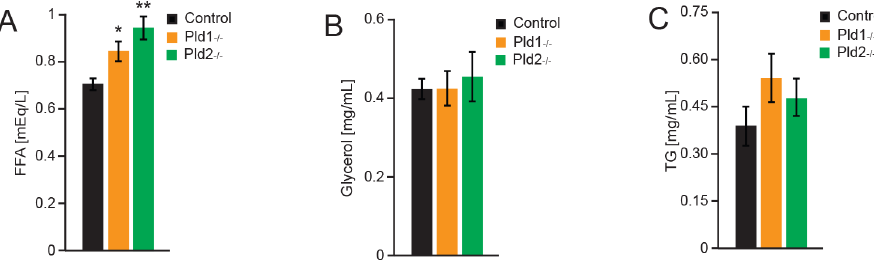
Fig 5. Free fatty acids in circulation are elevated in mice deficient for PLD1 or PLD2. A) Free fatty acids (FFAs), B) Glycerol, C) Triglycerides in circulation of 18-weeks old mice with indicated genotypes. Data represented as mean +/- S.E.M., n = 9 males for control (black), n = 6 males for Pld1 -/- (orange), n = 8 males for Pld2 -/- (green). * p < 0.05, ** p < 0.01, *** p <